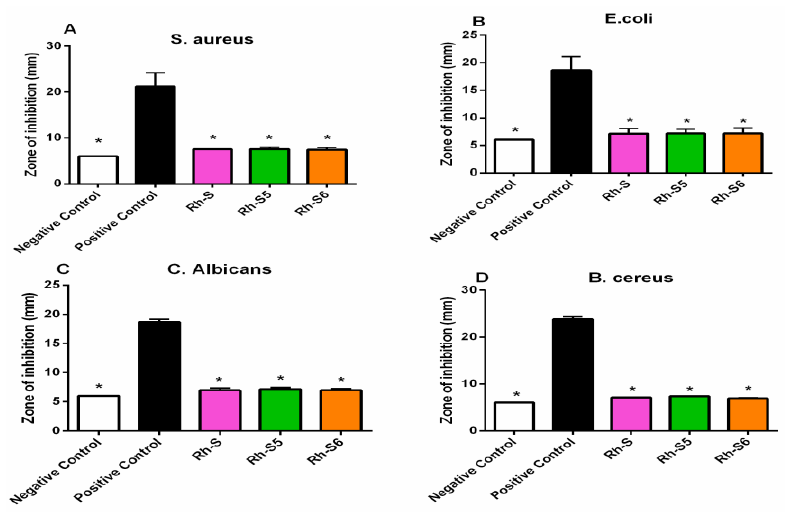
Figure 9. Graph of the diameter of the new peptide derivatives inhibitory zone against S. aureus bacteria ( A ), E. coli bacteria ( B ), C. albicans fungus ( C ), B. cereus bacteria ( D ), * p < 0.05 compared to the positive control group.